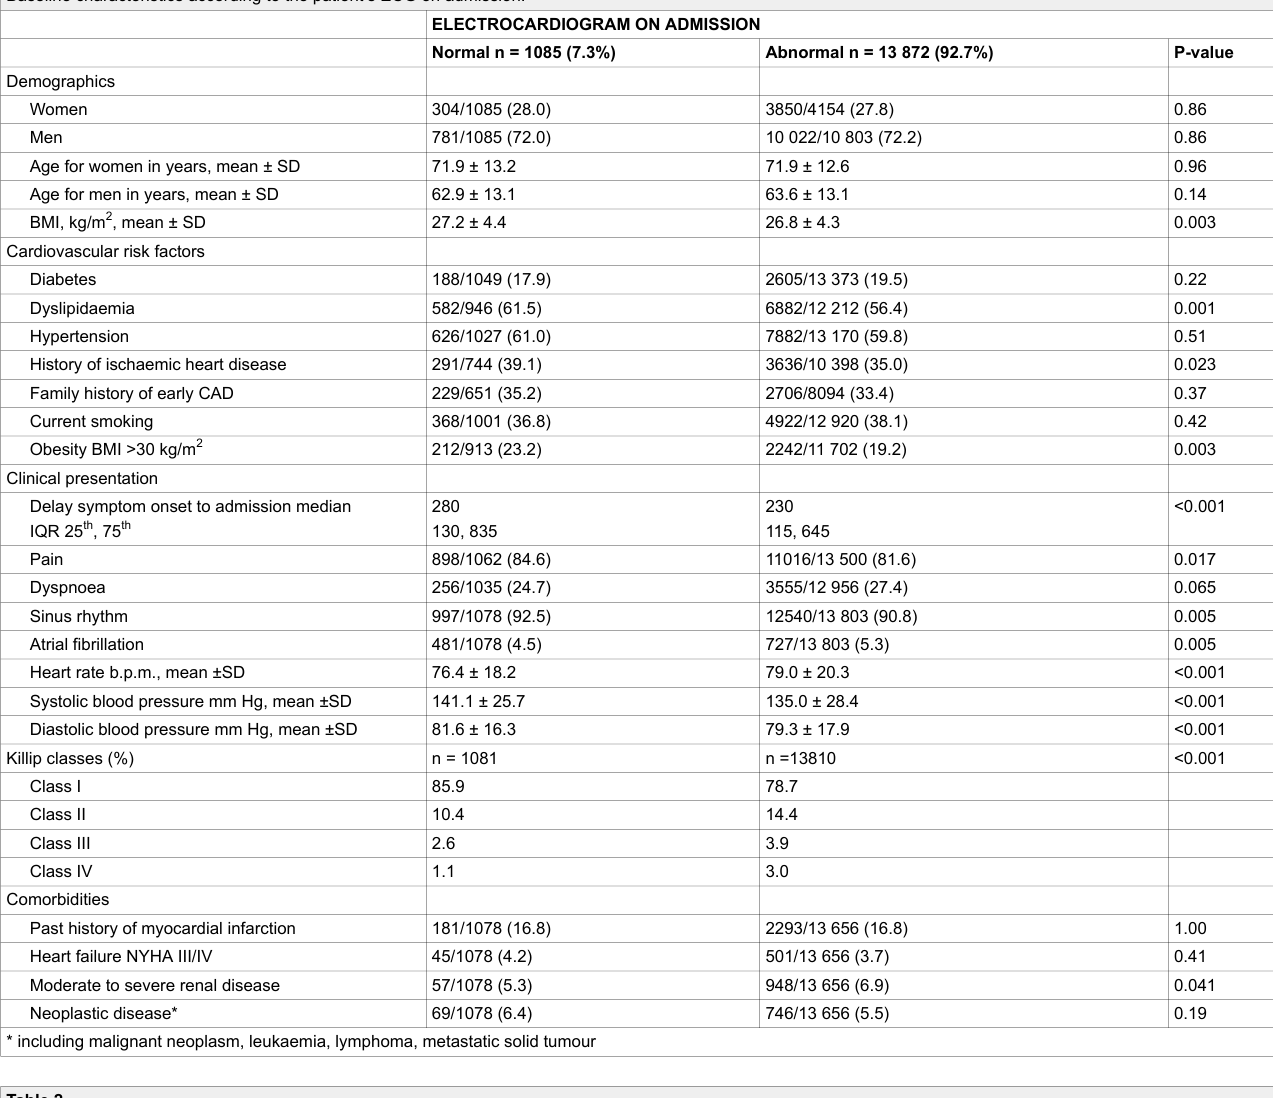
Table 1 Baseline characteristics according to the patient’s ECG on admission.